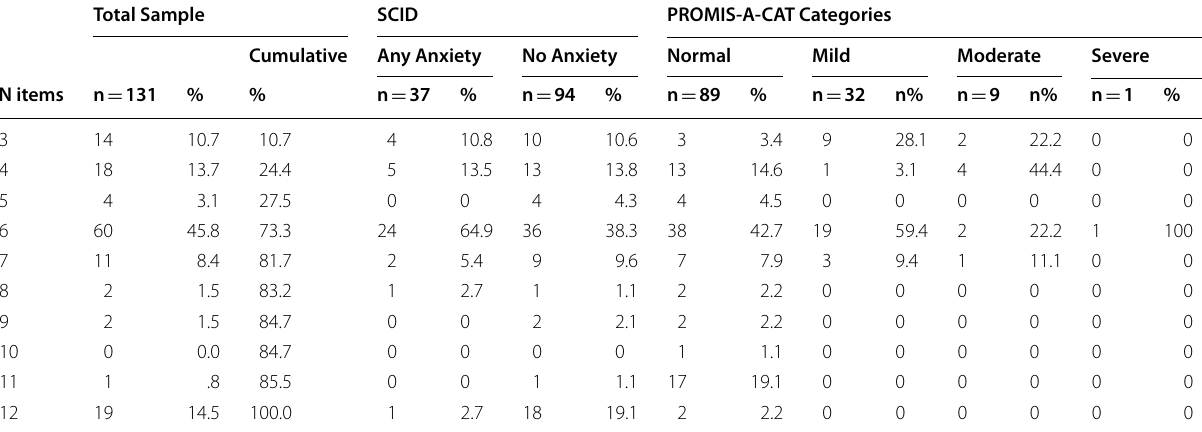
*Number of items in other anxiety measures: PROMIS-A-SF (8), HADS-A (7 for anxiety subscale), GAD-7 (7), DASS-A (7 for anxiety subscale), DASS-S (7 for stress subscale), DT (1), PSYCH-6